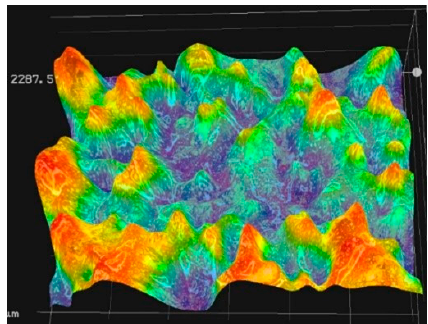
Figure 5. #80 initial contour morphology of the #80 mesh belt.